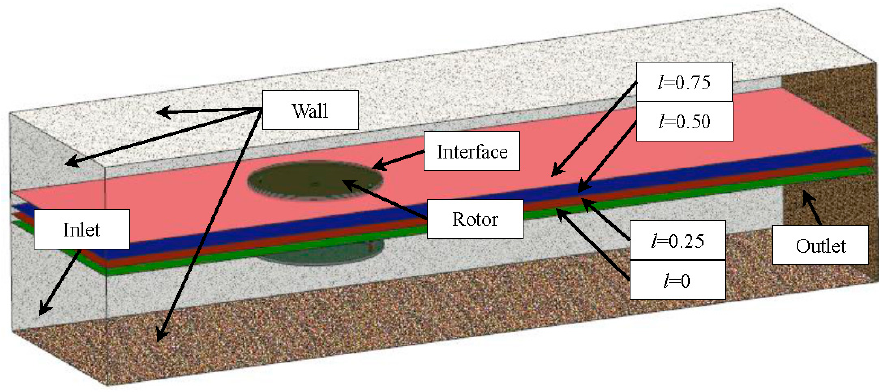
Figure 4. Boundary conditions of the numerical region of the CFD simulation and cross-sections of l = 0, 0.25, 0.50 and 0.75.